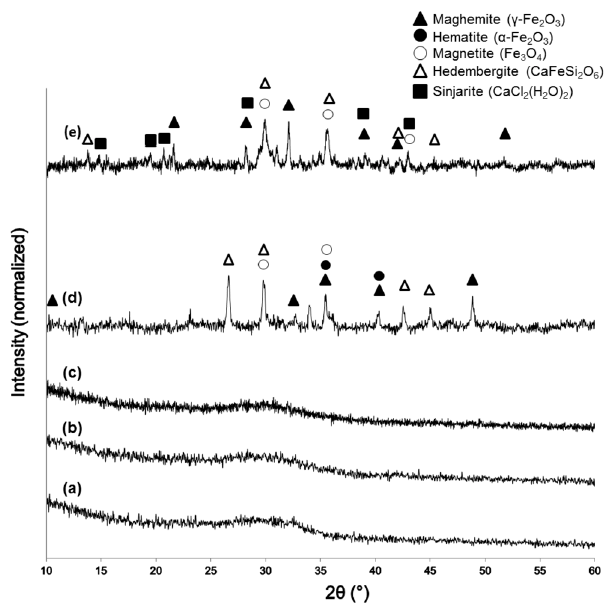
Figure 2. XRD patters of: ( a ) 60S40C-air; ( b ) 60S38C2Fe-air; ( c ) 60S38C2Fe-Ar; ( d ) 60S30C10Fe-air; and ( e ) 60S30C10Fe-Ar.